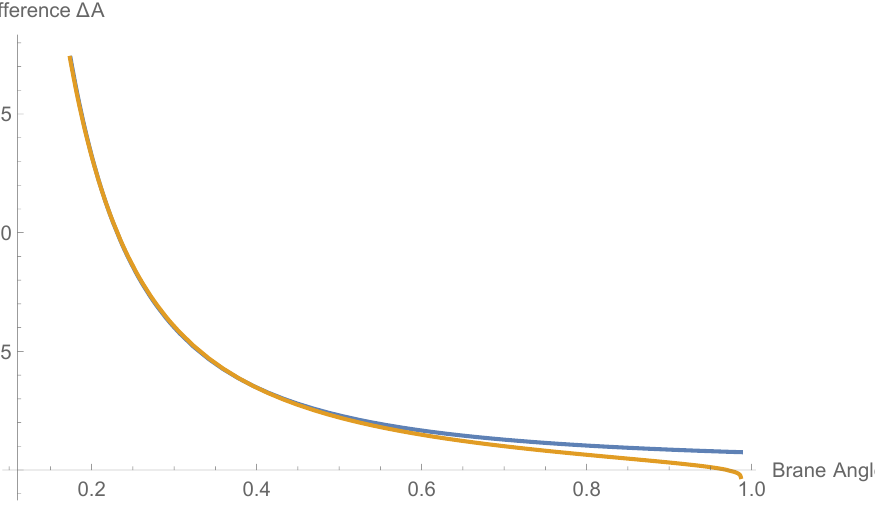
Figure 5: The t = 0 area difference (47) between the Hartman-Maldacena surface and the island surface, given as a function of brane angle is in orange, given for the black string at d = 4. This should be compared to the behavior of the brane’s induced ∼ 1 /θ 2 in blue. As we approach the critical angle the area Newton’s constant G − 1 N of the island surface approaches the area of Hartman-Maldacena in empty AdS. This means the difference becomes negative in the region near the critical angle, which ≈ for d = 4 is approximately θ c